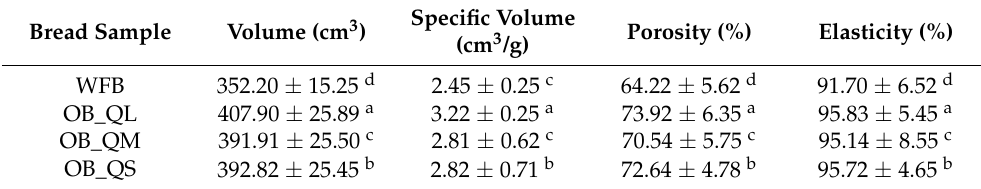
Table 3. Physical parameters of breads with the optimal dose corresponding to large, medium and small particle size of quinoa flour versus wheat flour bread. Specific Volume Volume (cm 3 ) (cm 3 /g)